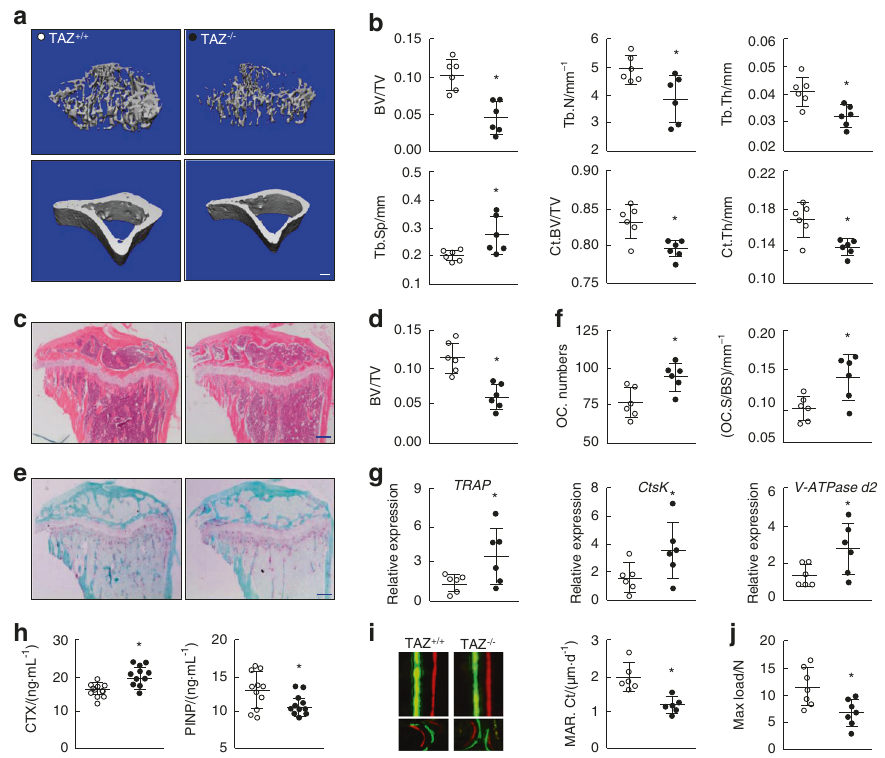
Fig. 2 Mice subjected to TAZ global knockout (KO) exhibit an osteoporotic phenotype. a 3D micro-CT reconstructions of the trabecular region below the tibial plateau and the cortical region of WT ( TAZ + / + ) and KO ( TAZ − / − ) mice. Scale bar denotes 200 μ m. b Quantitative morphometric assessment of micro-CT bone parameters, including trabecular BV/TV, Tb.N (mm − 1 ), trabecular thickness (Tb.Th, mm), trabecular separation (Tb.Sp, mm), cortical region BV/TV (Ct. BV/TV) and cortical thickness (Ct. Th, mm). c Histological H&E staining of tibial sections from TAZ + / + and TAZ − / − mice. Scale bar 200 µm. d Quantitative histomorphometric assessment of trabecular BV/TV based on H&E-stained tibial sections. e Histological TRAP staining of tibial sections from TAZ + / + and TAZ − / − mice. Scale bar denotes 200 μ m. f Quantitative assessment of osteoclast numbers (OC.N/BS) and osteoclast surface relative to total bone surface (OC.S/BS) based on TRAP-stained tibial sections. g Real-time qPCR analysis of the expression of osteoclast marker genes in forelimb bones. h ELISA assessment of serum CTX and P1NP levels in TAZ + / + and TAZ − / − mice. i Periosteal mineral apposition rate (MAR) by calcein-alizarin red double labeling. The upper panels represent cortical bone (Ct), and the lower panels represent trabecular bone (Tb). j Mechanical three-point bending tests of maximum load bearing of the tibial bone. ○ and ● represent the TAZ + / + and TAZ − / − groups, respectively. An unpaired Student ’ s t -test was performed. * P < bone volume for tibias from OVX mice than for tibias from the sham control mice (Fig. 1g). Again, the expression of the TAZ gene reconstruction images and quantitative morphometric assessments was downregulated in the OVX group compared with the sham of the vertebral bone (Supplementary Fig. 3e, f) and the skull control group (Fig. 1h). Collectively, these results suggested that (Supplementary Fig. 3g, h) further supported the osteoporotic TAZ expression is downregulated in osteoporosis. phenotype in TAZ − / − mice. The bone tissue microarchitecture was further assessed by histological staining of tissue sections with H&E. The low-bone mass osteoporotic phenotype of TAZ − / − mice was evident in H&E-stained tissue samples (Fig. 2c) and con fi rmed by